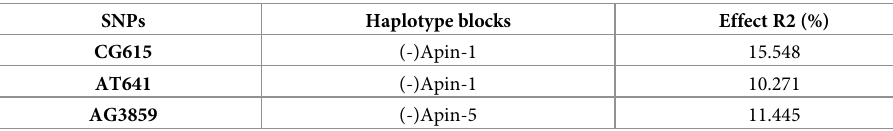
Table 4. Overview of SNPs association with α -pinene content.